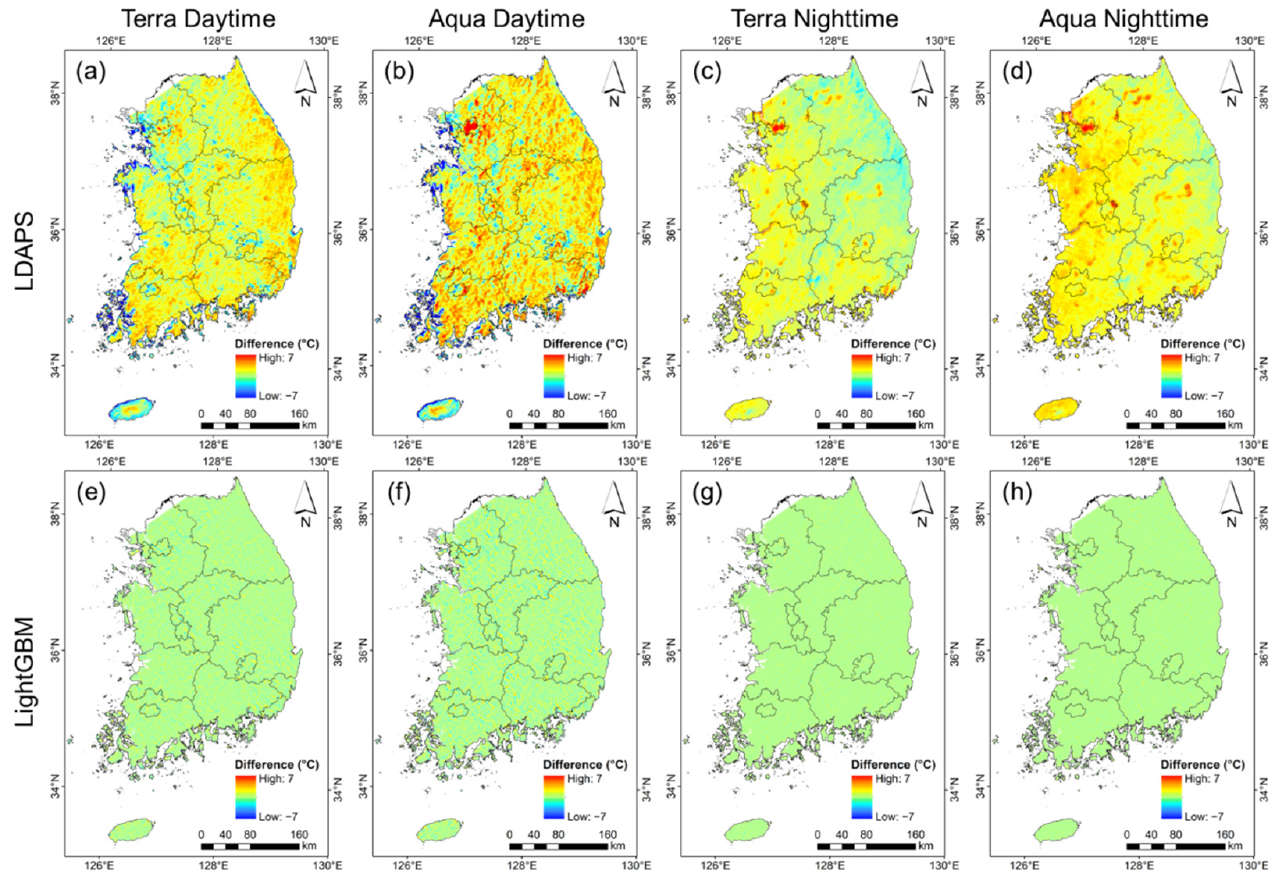
Figure 4. LST difference between the ( a - d ) LDAPS and ( e - h ) the proposed LightGBM model for four clear-sky LSTs (i.e., Terra and Aqua for daytime and nighttime). The difference maps of the LightGBM model were produced from the SPCV results. The performances of LDAPS and LightGBM by land cover are depicted in Figure 5. The LightGBM outperformed LDAPS in the four different land covers for all MODIS view times, producing higher R 2 and lower RMSE . Except for built-up areas, the proposed LightGBM model had an R 2 ≥ 0.80 and RMSE ≤ 1.6 ◦ C during the daytime, and an R 2 ≥ 0.95 and RMSE ≤ 0.7 ◦ C at nighttime. Among four different land covers, the LightGBM model generally had the highest accuracy in forest areas but was less accurate in the built-up class than other land